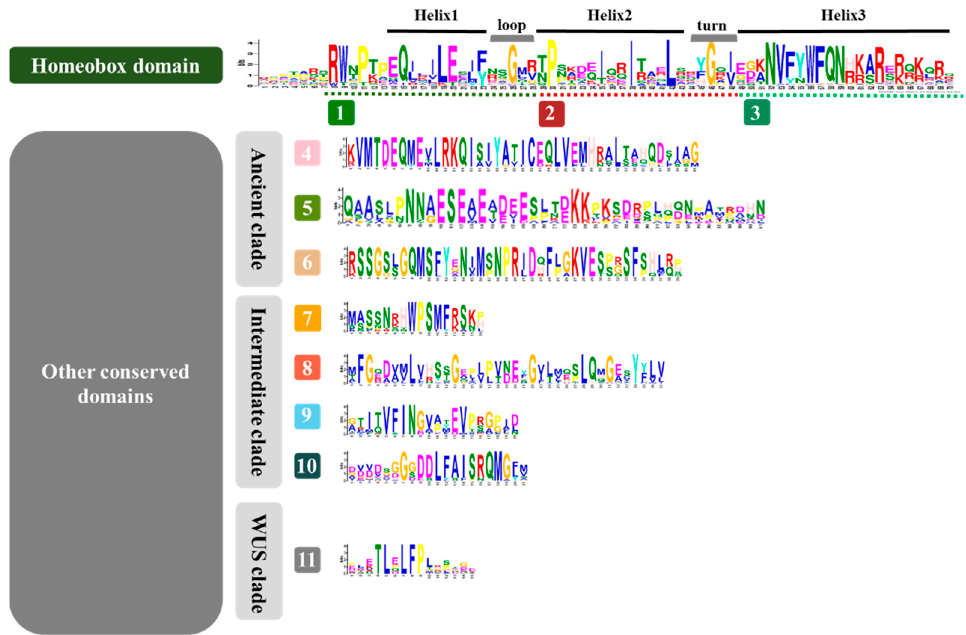
Figure 1. The conserved domains identified in the WUSCHEL-related homeobox (WOX) family. Eleven conserved domains were identified among 15 AtWOXs, 18 PotriWOXs, 13 OsWOXs, 20 ZmWOXs, 27 PheWOXs, 13 BradiWOXs, 12 OlaWOXs, 9 RguWOXs, 18 GanWOXs, and 26 BamWOXs by Multiple Em for Motif Elicitation (MEME). Motifs 4-6 were identified in the WOXs belonging to the ancient clade. Motifs 7-10 were identified in the WOXs belonging to the intermediate clade. Motif 11 was found in the WOX belonging to the WUS clade.